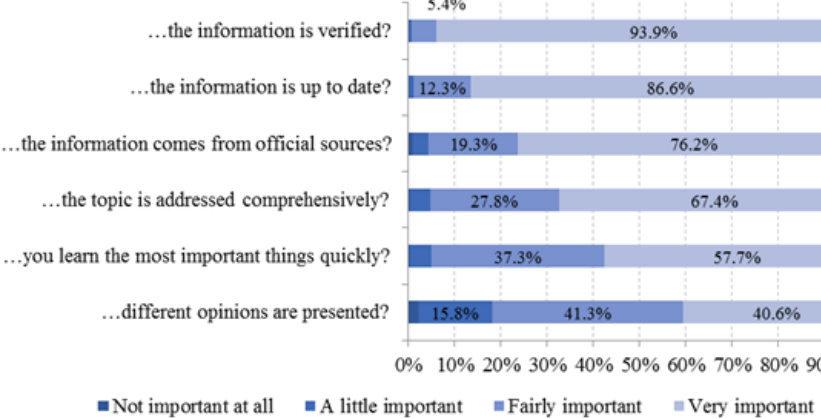
Figure 3. Frequency of perceived importance of aspects in COVID-19 information-seeking. ‘How important is it for you that . . . ’ ( n = 3045 to 3052).